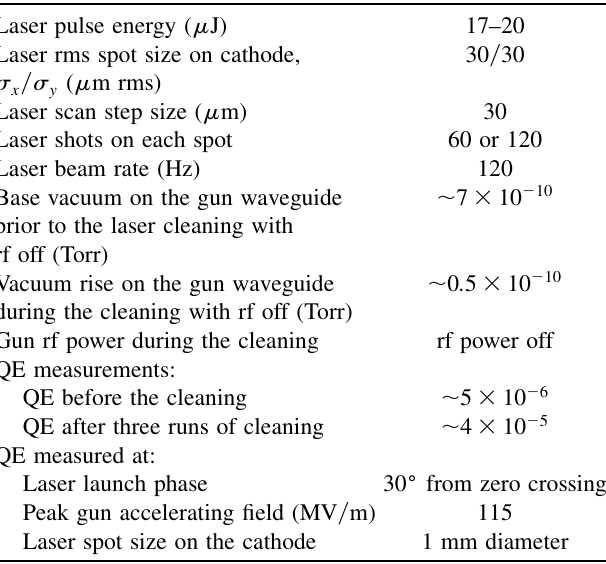
TABLE I. Major parameters for the cleaning of the third LCLS